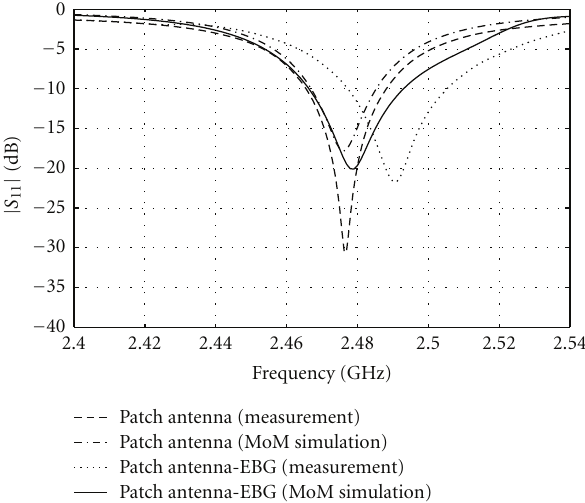
Figure 6: Simulation and measurement comparison between the prototypes: patch antenna and patch antenna-EBG.